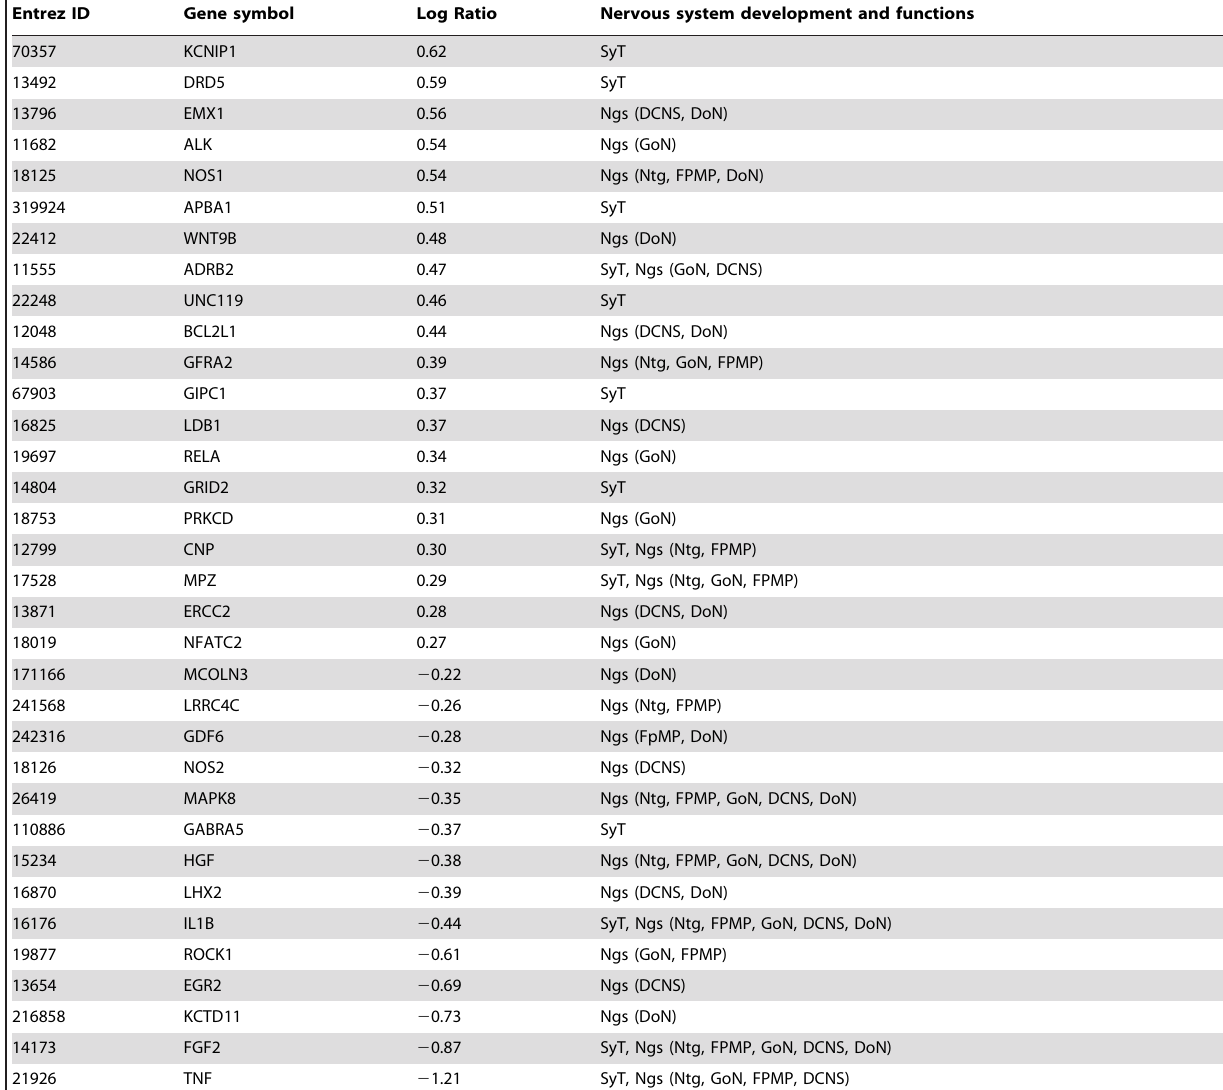
Entrez ID Gene symbol Log